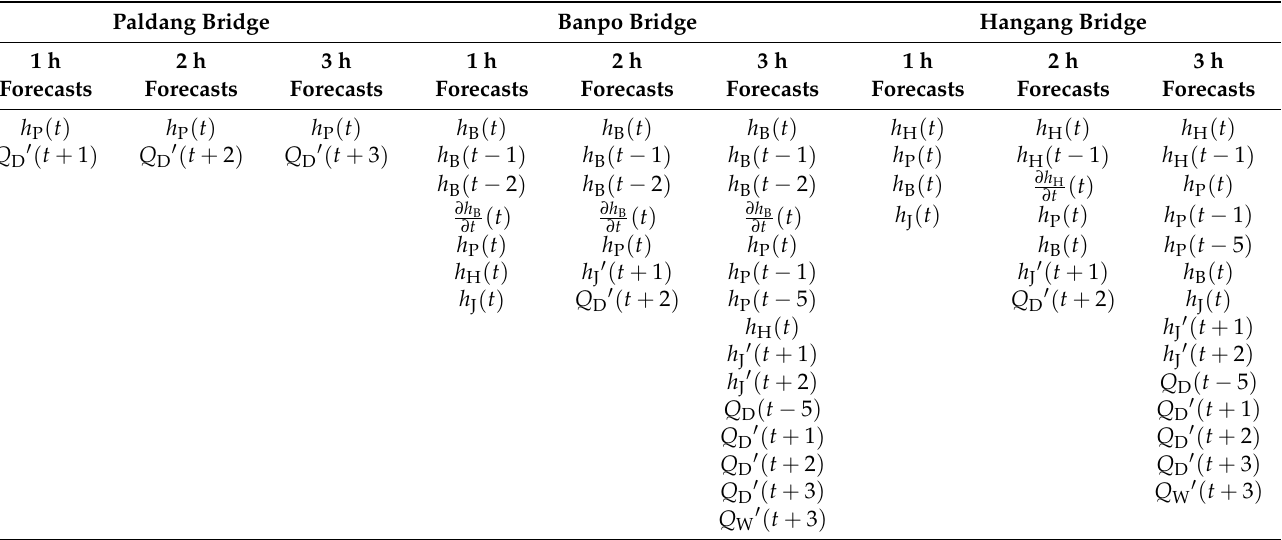
Table 3. Selected input variables for